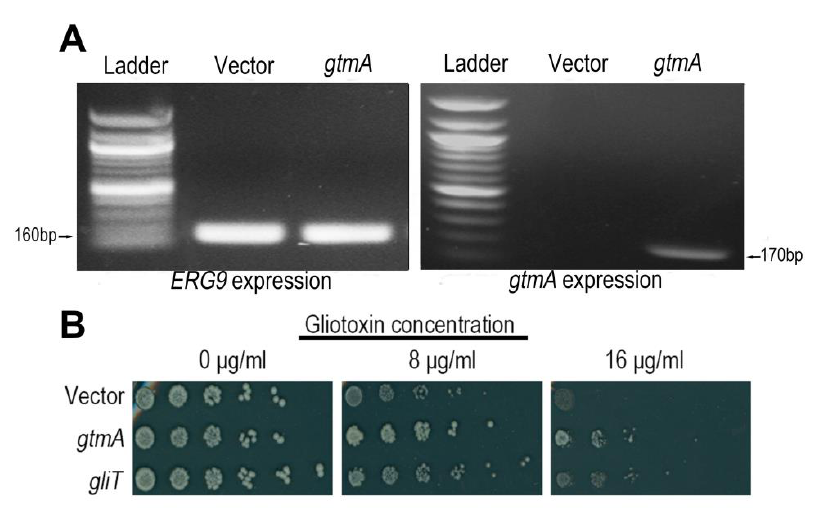
FIGURE 2: Expression of gtmA in yeast protects against GT cytotoxicity. (A) RT-PCR demonstrating that gtmA mRNA is stably expressed in yeast. Yeast ERG9 mRNA pro- duction is shown as a positive control. (B) Expression of A. fumigatus genes gtmA or gliT in yeast provides protection against GT